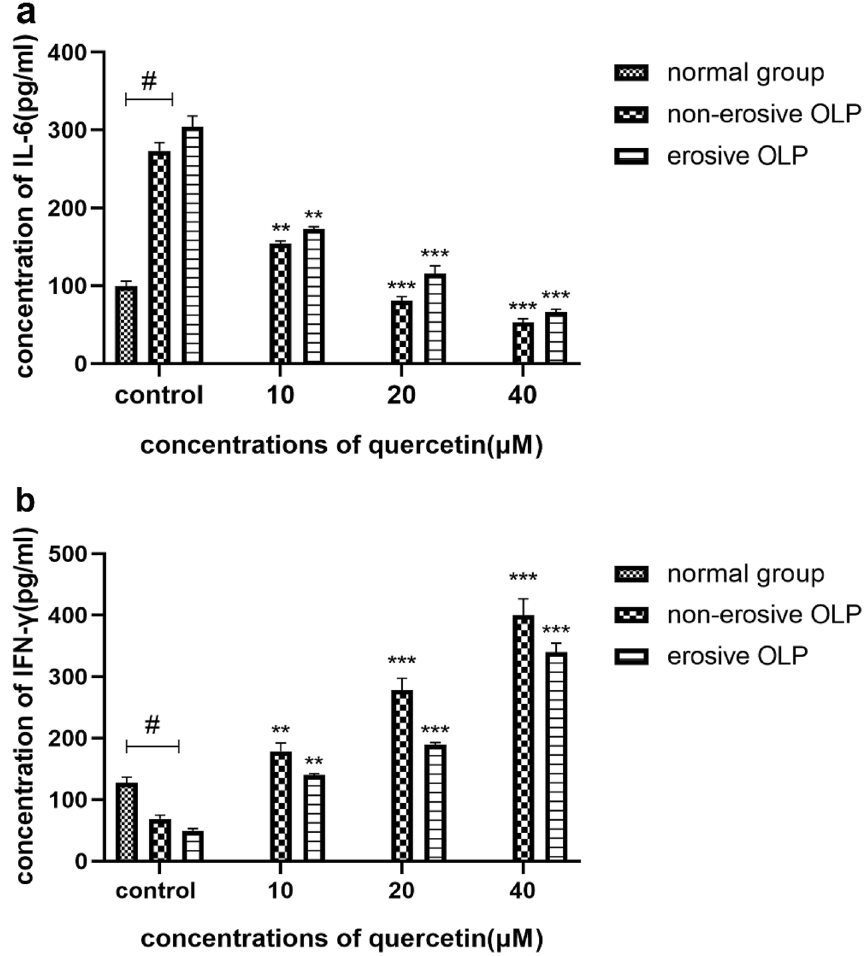
Figure 10. After the incubation with different concentrations of quercetin for 24 h, the expression level of IL-6 ( a ) and IFN-γ ( b ) in the T lymphocytes culture supernatant of the none-erosive and erosive OLP patients was assessed by ELISA. ( a ) showed that the 10, 20, and 40 μM quercetin group had a considerably lower expression of IL-6 in the patients with OLP than the control group. The normal group had lower expression of IL-6 than OLP patients. ( b ) Meanwhile, the 10, 20, and 40 μM quercetin group induced a significantly higher IFN-γ protein level in the patients with OLP than the control group. The normal group had higher expression of IFN-γ than OLP patients. (** p < 0.01, *** p < 0.001 versus the control group of OLP, # p < 0.05 versus OLP group, n =